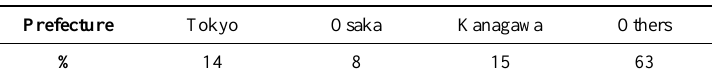
Table 2. Respondents’